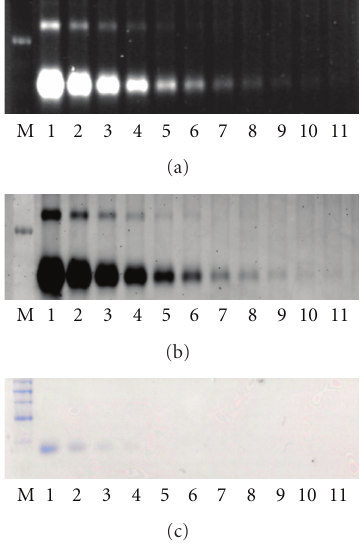
Figure 2: Specificity testing of LRSH glycoprotein stain dye. Two- fold serial increases in the nonglycoprotein (BSA)/glycoprotein (horseradish peroxidase, HRP) ratio, ranging from 1 μ g/1 μ g to 32 μ g/1 μ g. M represents standard protein molecular weight mark- ers. (a) UV 305-nm excitation and CCD camera detection in a UV transilluminator. (b) Poststaining of the same gel with Coomassie